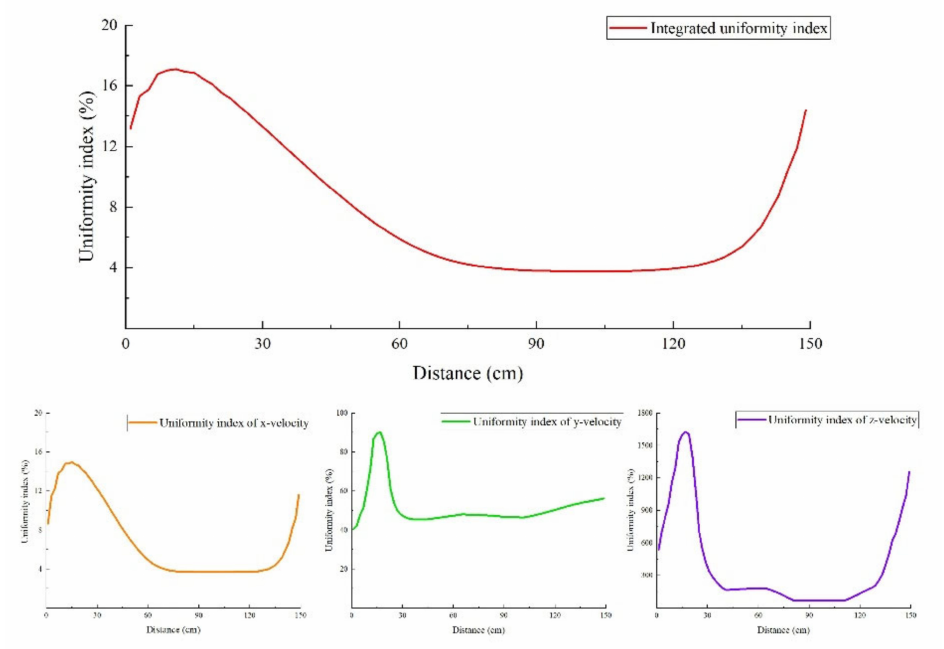
Figure 6. The distribution of 3D velocity uniformity along the path in straight